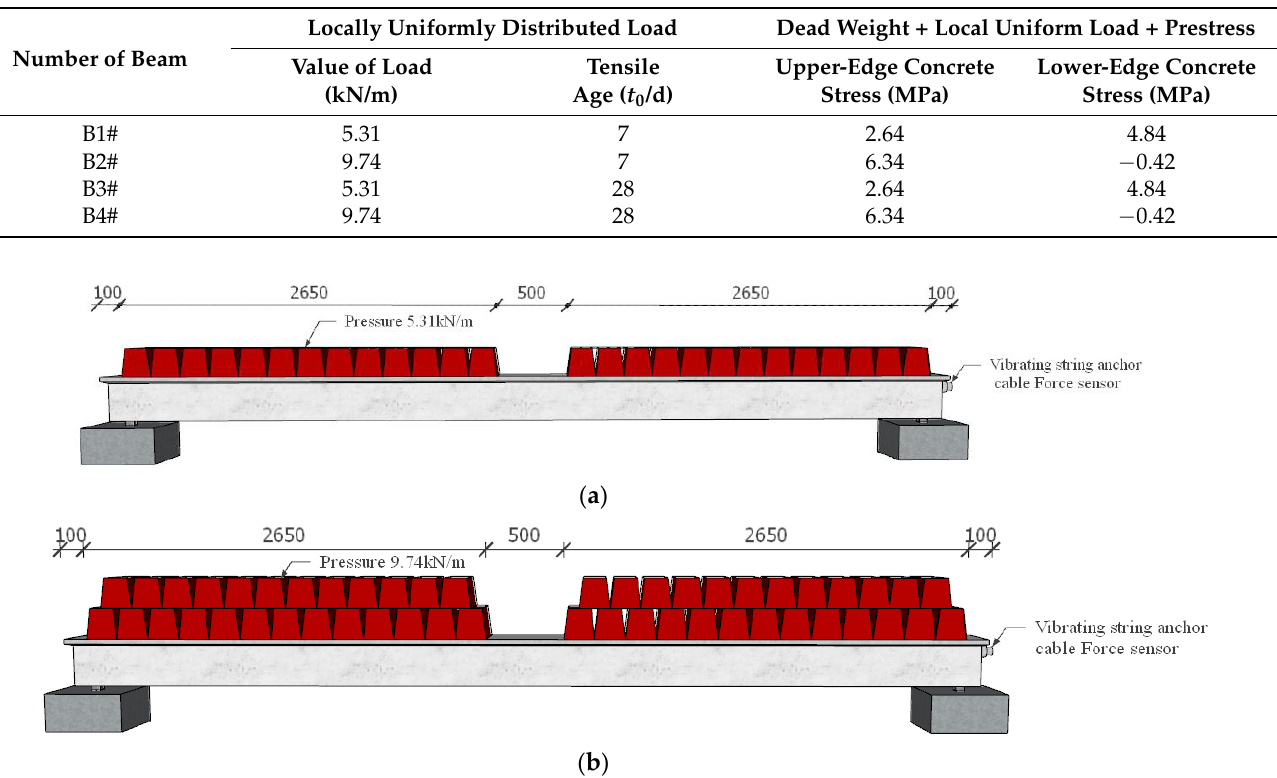
Figure 4. Loading of T-beam (unit: mm): ( a ) loading status of B1# and B3#; ( b ) loading status of B2# and B4#.